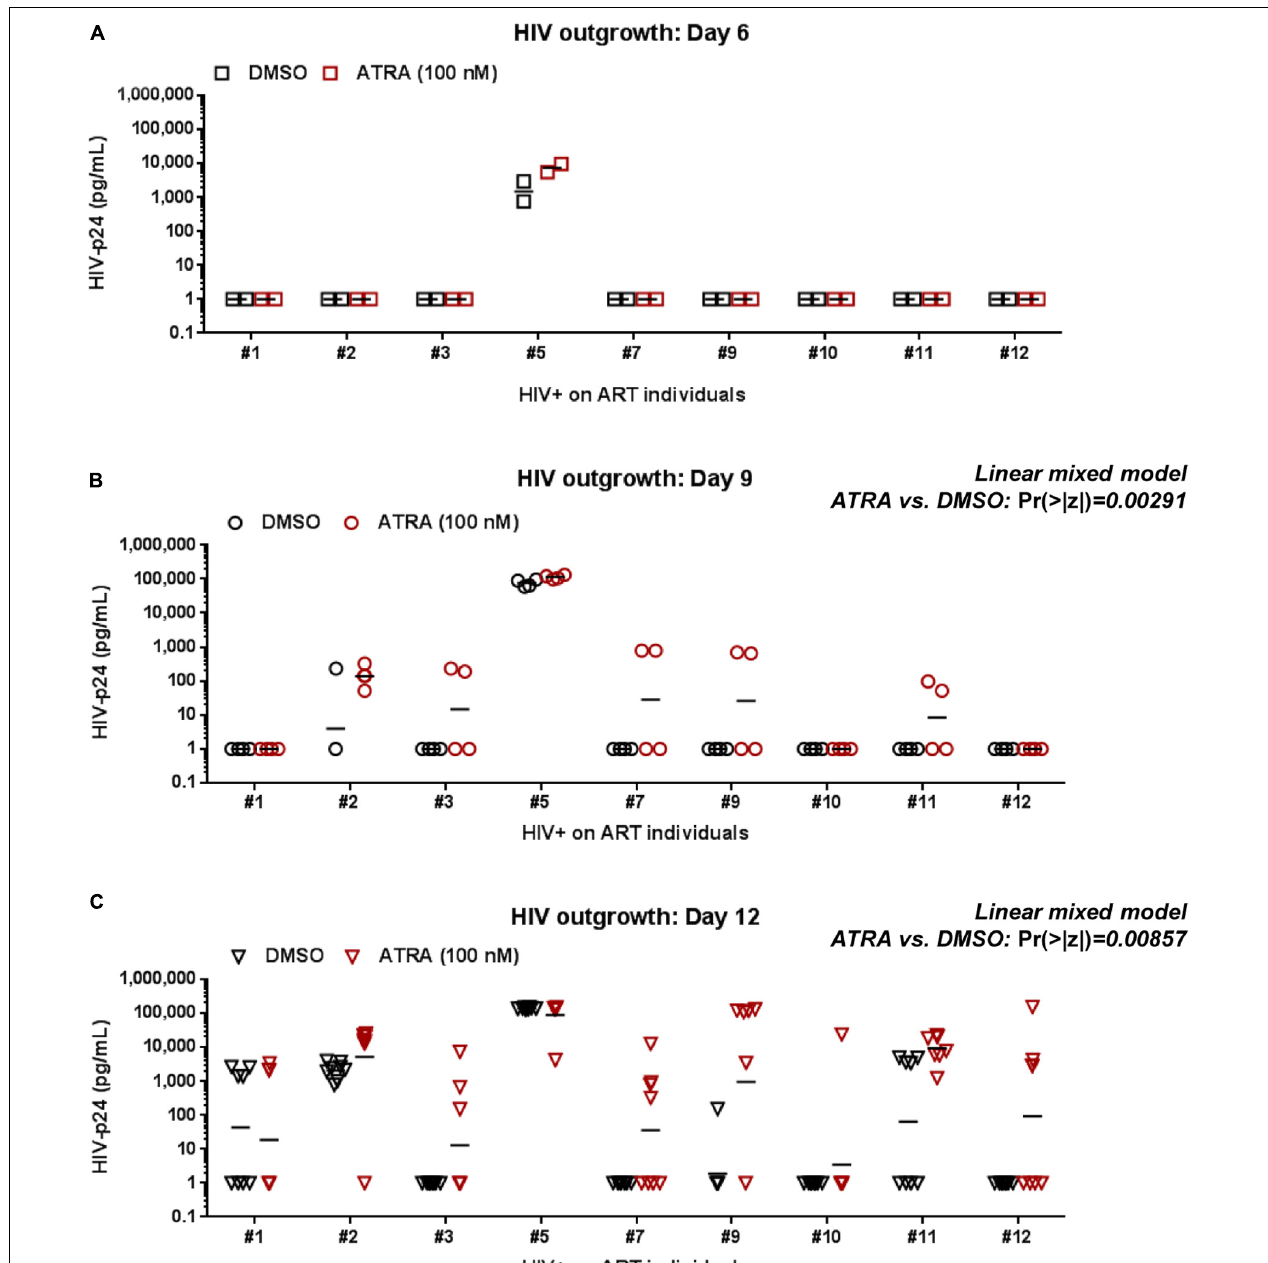
FIGURE 3 | ATRA boosts HIV outgrowth. The VOP was performed with memory CD4 + T-cells of ART-treated PLWH ( n = 9 HIV+ART individuals; Supplementary Table S1 ) in the presence (red symbols) or absence (black symbols) of ATRA (100 nM), as described in Figure 1 . Shown are absolute HIV-p24 levels quantified in cell-culture supernatants collected from splitting replicates at days 6 (2 wells) (A) , 9 (4 wells) (B) , and 12 (8 wells) (C) post-culture. The horizontal black lines indicate the geometric means in (A–C) . Linear mixed model Pr ( > |z|) values are indicated on the graphs for the comparison ATRA versus DMSO at Day 9 and Day 12 (details in Supplementary Table S4